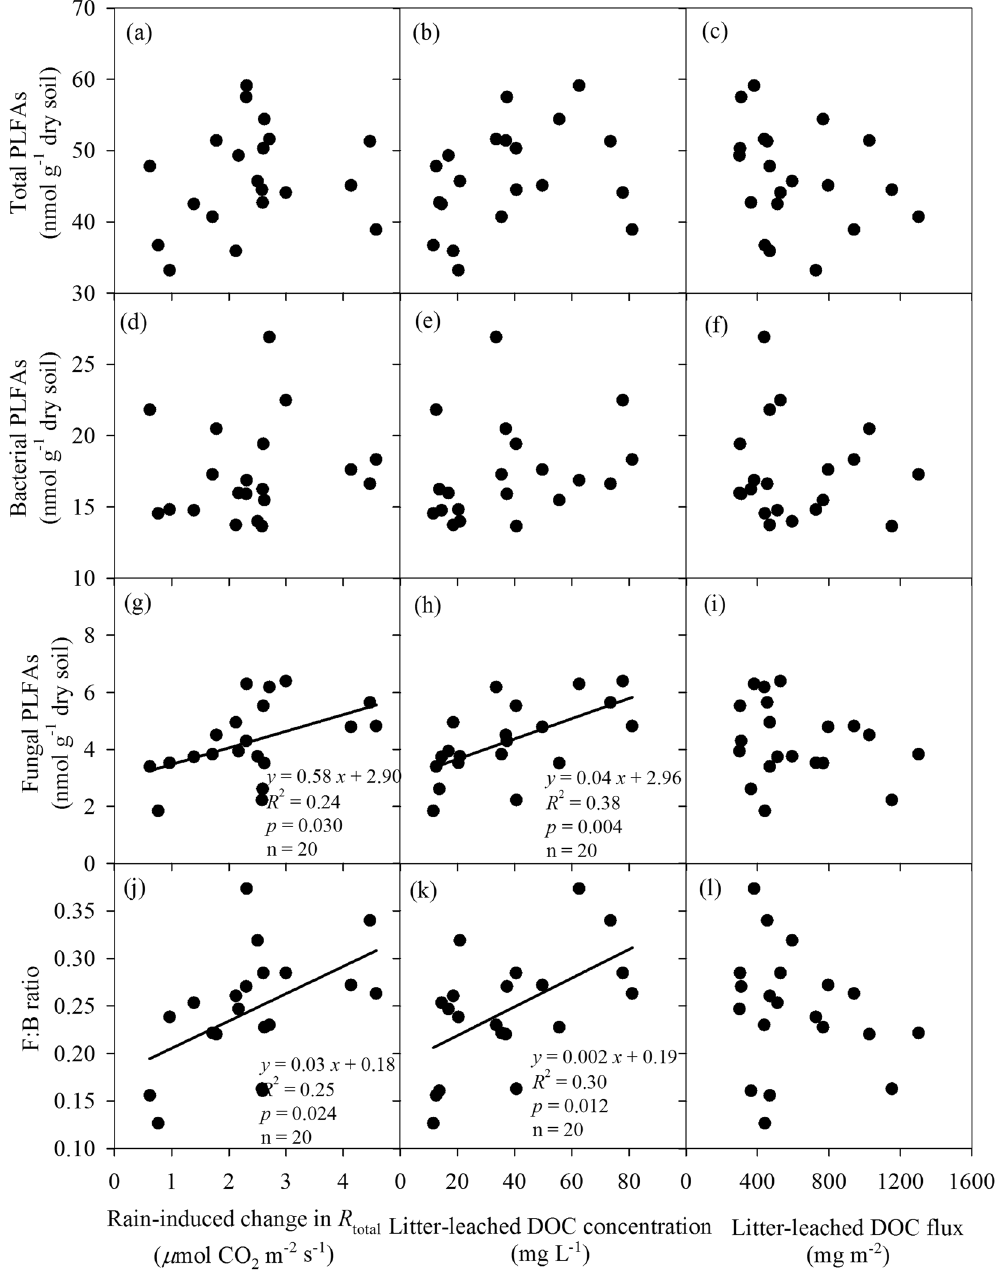
Figure 6. Relationships of soil microbial PLFAs changes after simulated rains with the concentrations of litter- leached dissolved organic carbon